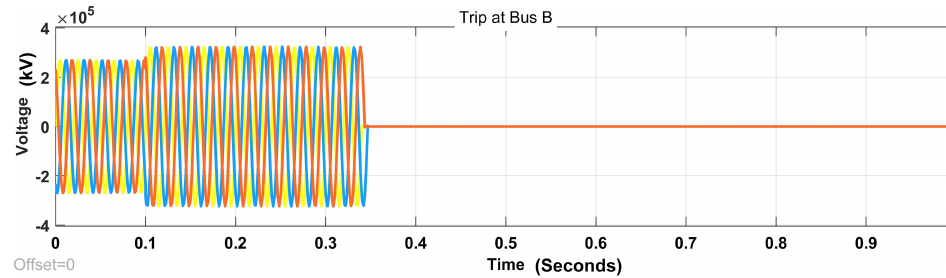
Figure 7. Overvoltage. Trip at Bus B.